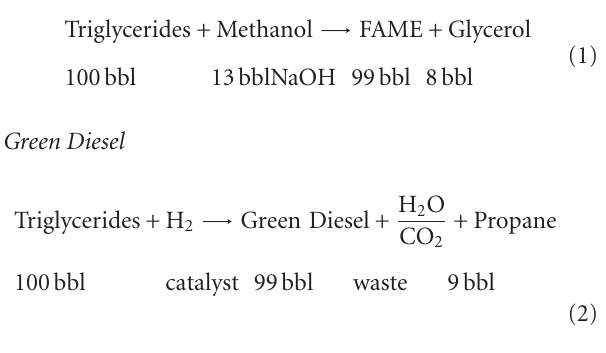
[49–51]. Another noxious weed is Kudzu with similar pyrolysis benefits with roots a source of starch and some edible